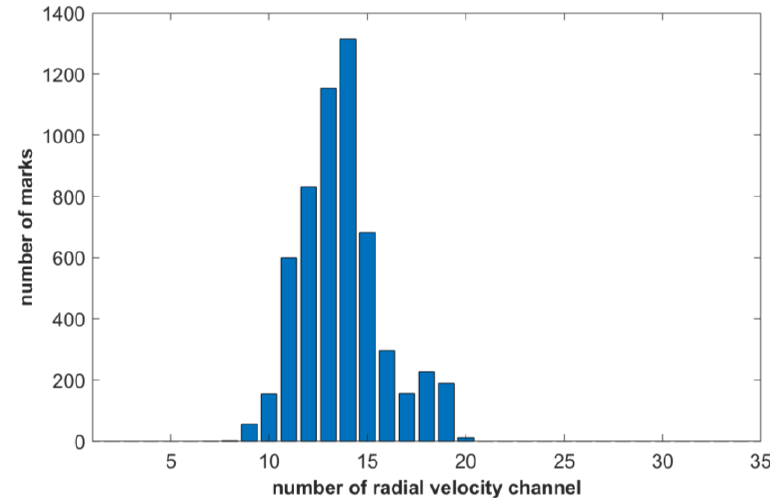
Fig. 4. The example of clutter radial velocity distribution for i = const , j = const , k = const . The information about the marks is gathered from 3 scan